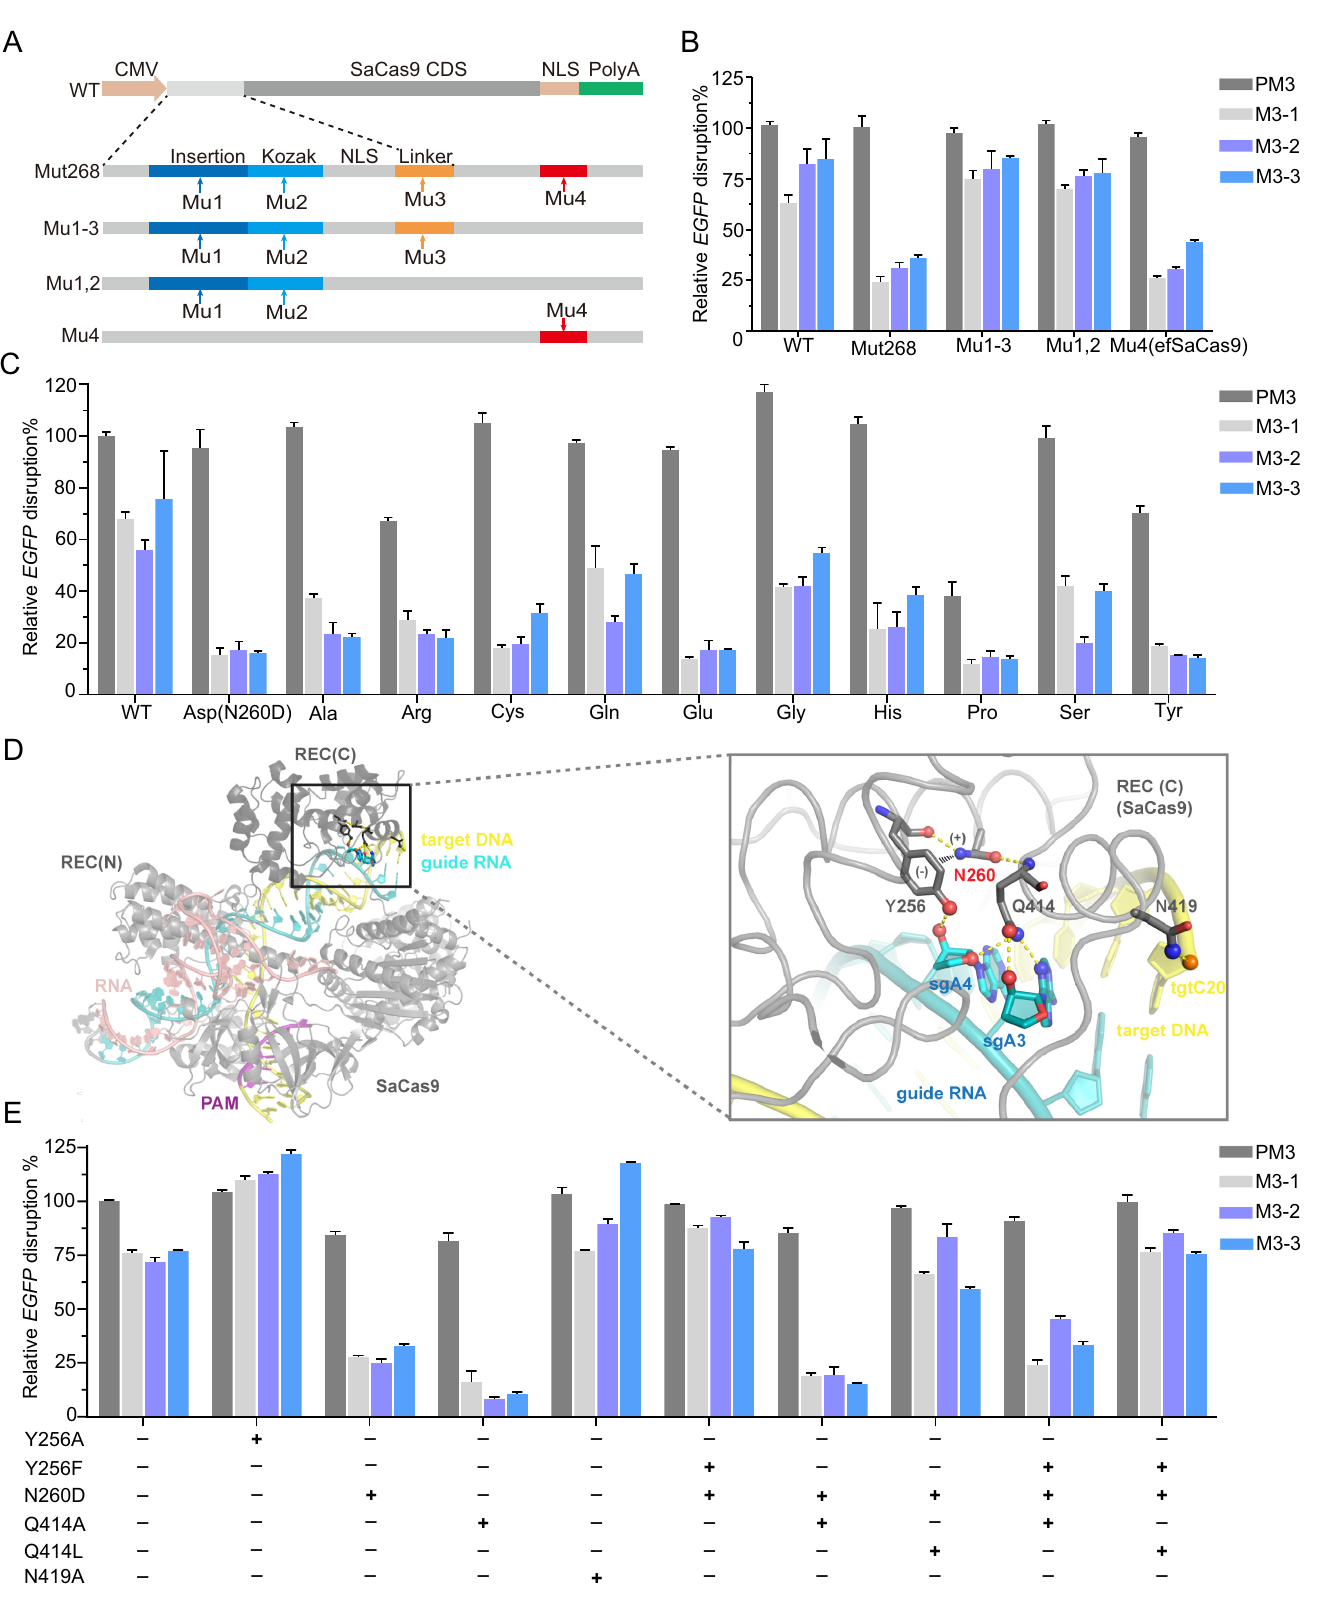
Fig 4. Structural insights of enhanced fidelity. (A) Strategy for mapping the responsible mutation(s). (B) Relative EGFP disruption of site 3 with variants harboring different mutation(s). Relative disruption efficiencies are normalized to the perfect-matched sgRNA target site 3 recognized by WT SaCas9; error bars, SEM; n = 3. (C) Effects of single amino-acid substitutions of N260 on SaCas9 editing activity and fidelity. (D) Structural context of efSaCas9. Left panel: Overall structure of a ternary PLOS Biology | https://doi.org/10.1371/journal.pbio.3000747 July 9,